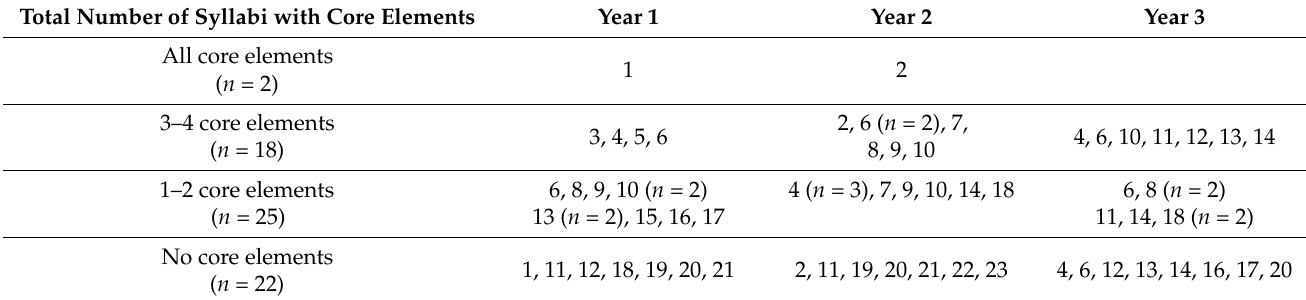
Table 1. Overview of course syllabi according to year and number of core elements. Total Number of Syllabi with Core